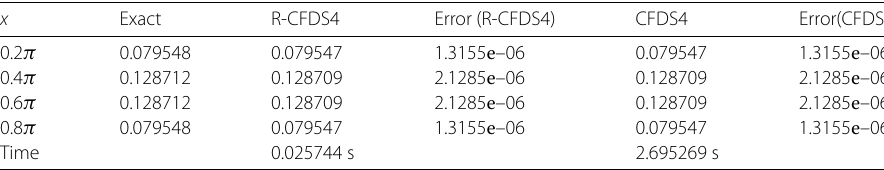
Table 1 Numerical results of SP 1 at t = 2, with h = 0.02 π , τ = 0.01